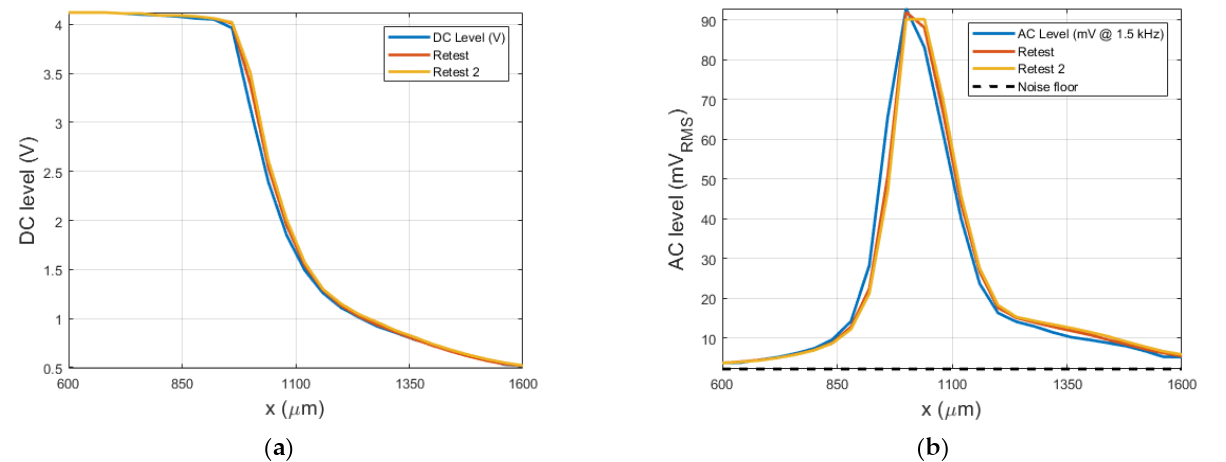
Figure 11. ( a ) Amount of light transmitted through the airgap as a function of the obstruction distance x. ( b ) Dynamic response when inducing a vibration using a Carina T2 middle ear actuator stimulated with a 1500 Hz 0.5 Vrms sine wave. Three datasets are shown, including the system noise floor (black, panel ( b )) for the sensitivity curve.